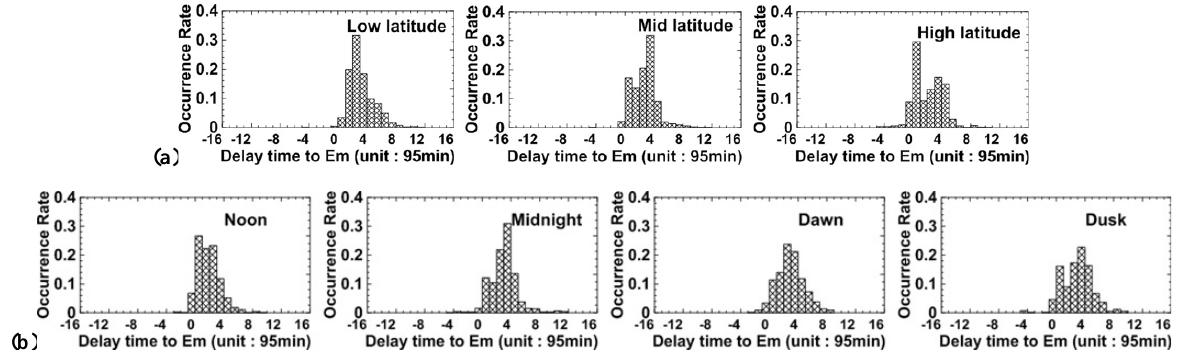
Fig. 11. Distribution of delay times of the storm-time density changes in respect to E m at different latitudes containing all local time sectors (a) and at different local time sectors containing all latitudes (b)